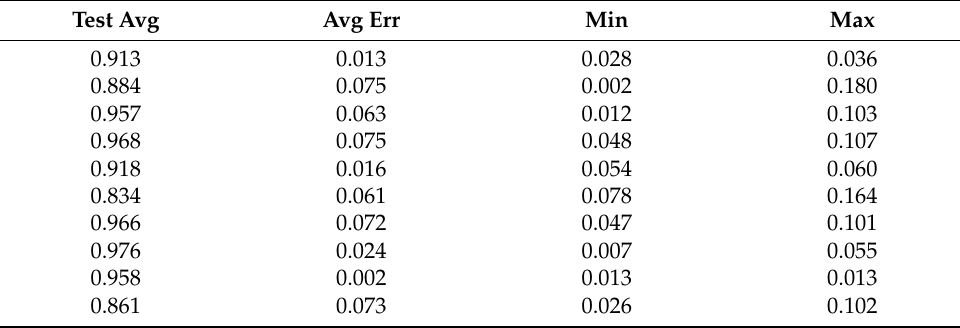
Table A100. Set 2, trials 11–20 data (actual PR